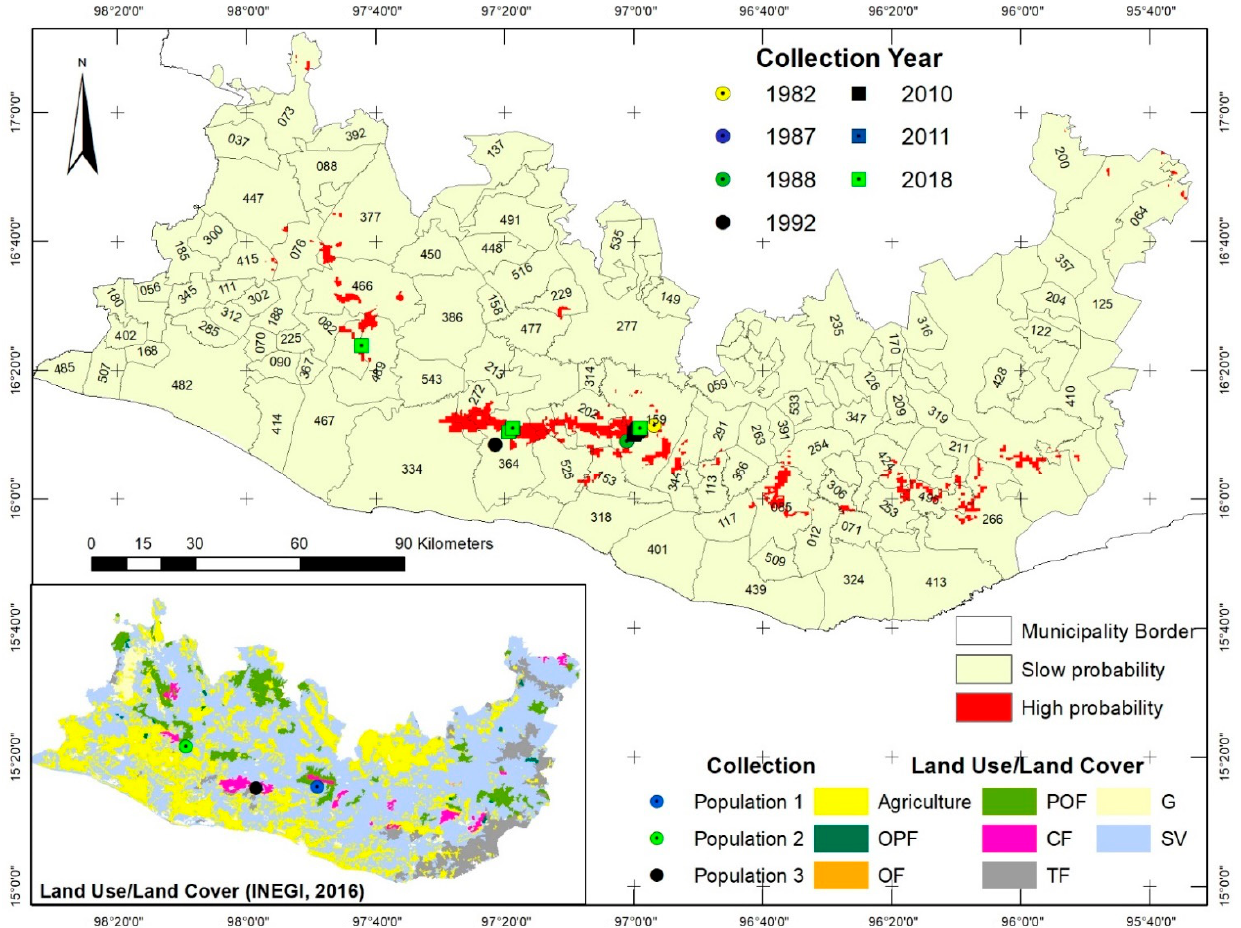
Figure 2. Potential distribution of Euphorbia fulgens in the Sierra Sur and Costa regions of Oaxaca. The analysis of the soil samples showed that the sites have similar characteristics. They are sandy–loam textured soils, with pH values 5.0, EC < 0.06 dS m − 1 , and a bulk densities (BD) of 1.0 g cm − 3 . The soil of population 1 contained 53.3% sand, 29.3% silt, and 17.2% clay. The soil of population 2 presented 55.5% sand, 31.3% silt, and 13.2% clay, while the soil of population 3 contained 65.9% sand, 16.0% silt, and 18.1% clay. The soil of population 1 had the lowest organic matter content (4.48%). The soil of population 2 had higher Ca (910 mg kg − 1 ), Mg (227 mg kg − 1 ), Fe (110 mg kg − 1 ), Zn (1.28 mg kg − 1 ), and Mn (14.56 mg kg − 1 ) contents compared to the other populations (Table